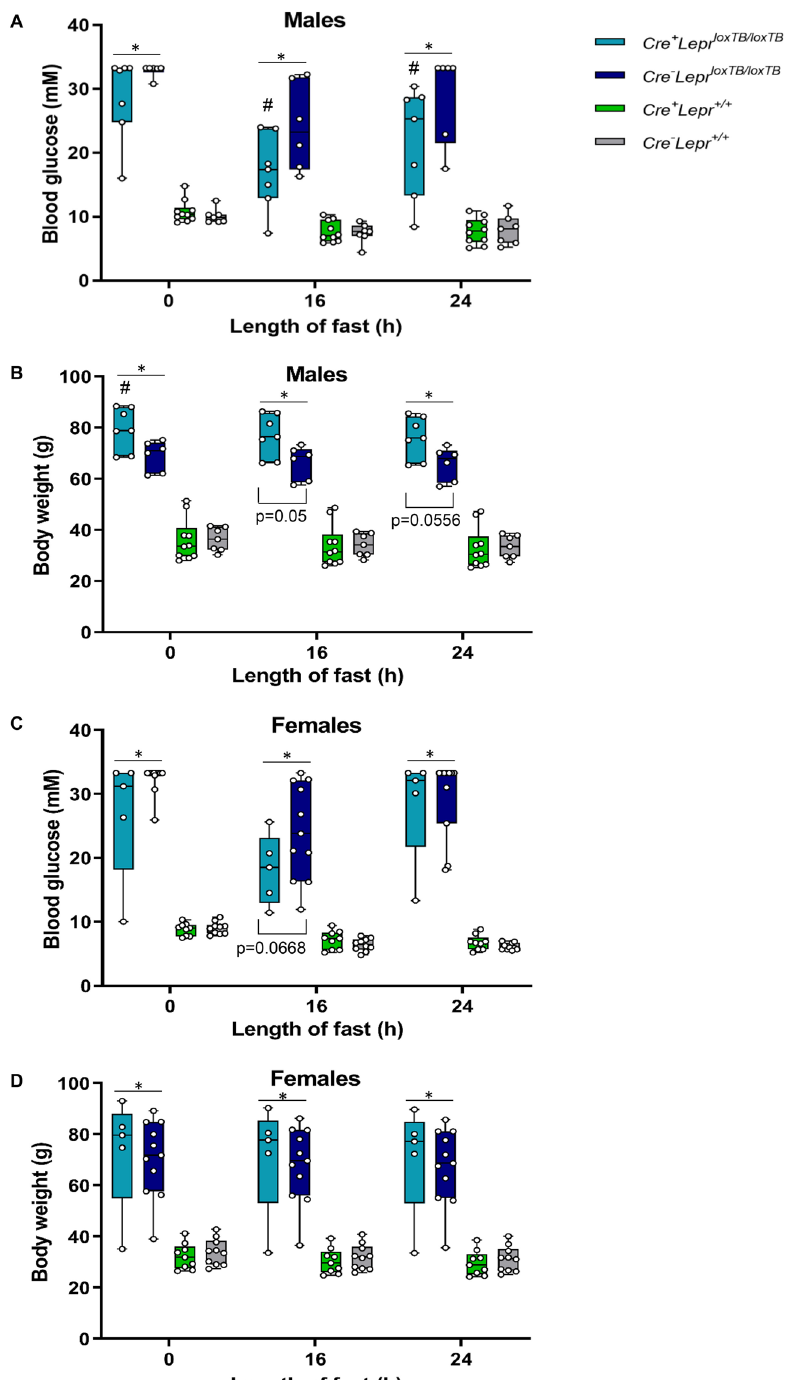
Figure 5. Blood glucose concentration ( A , C ) and body weight ( B , D ) of mice from the Lepr reconstitution study at different fasting times. In ( A ) and ( B ), n = 7 for Cre + Lepr loxTB/loxTB , n = 6 for Cre − Lepr loxTB/loxTB , n = 10 for Cre + Lepr + / + , and n = 7 for Cre − Lepr + / + . In ( C ) and ( D ), n = 5 for Cre + Lepr loxTB/loxTB , n = 11 for Cre − Lepr loxTB/loxTB , n = 9 for Cre + Lepr + / + , and n = 10 for Cre − Lepr + / + . Performed repeated measures two-way ANOVA with post- hoc analysis. *p < 0.05, Cre + Lepr loxTB/loxTB and Cre − Lepr loxTB/loxTB vs. Cre + Lepr + / + and Cre − Lepr + / + ; # p < 0.05 vs. Cre − Lepr loxTB/loxTB . Main effect of time (p < 0.05) in ( A – D